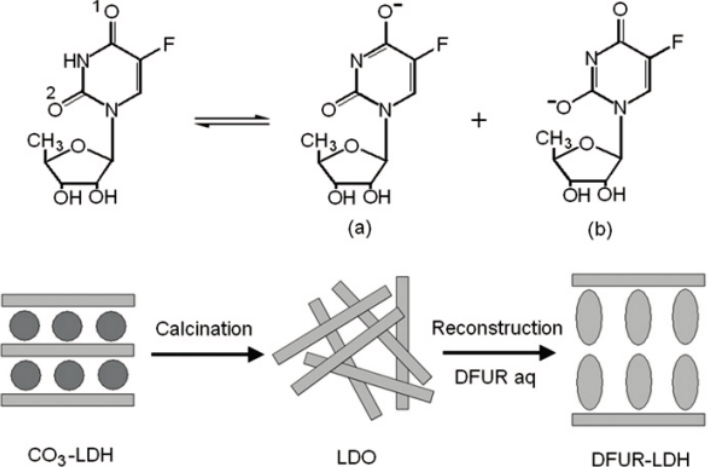
Figure 16. Resonance structure of doxifluridine (DFUR) and the synthetic strategy